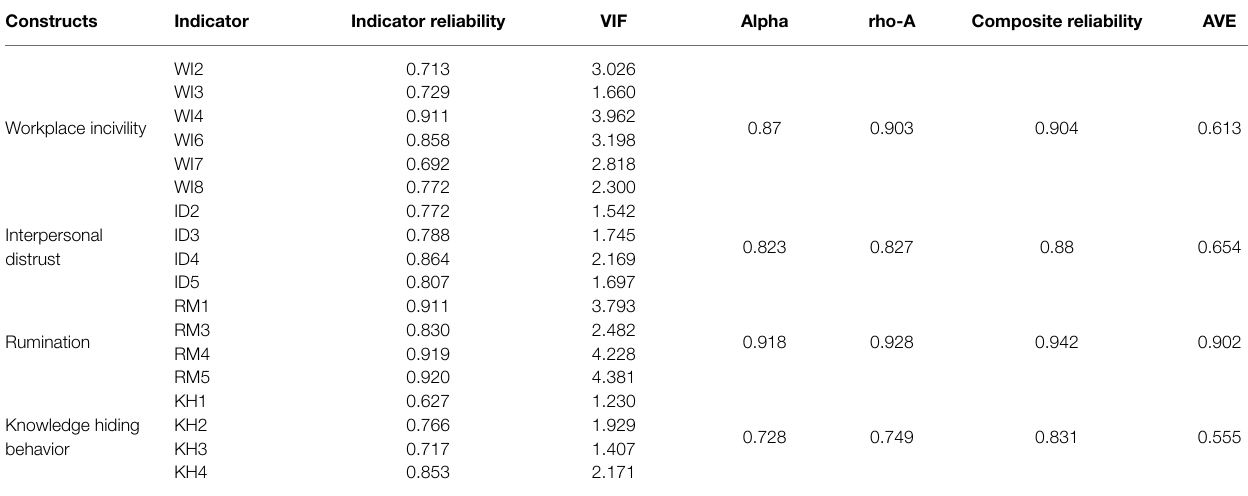
TABLE 1 | Reliability and convergent validity of the constructs.